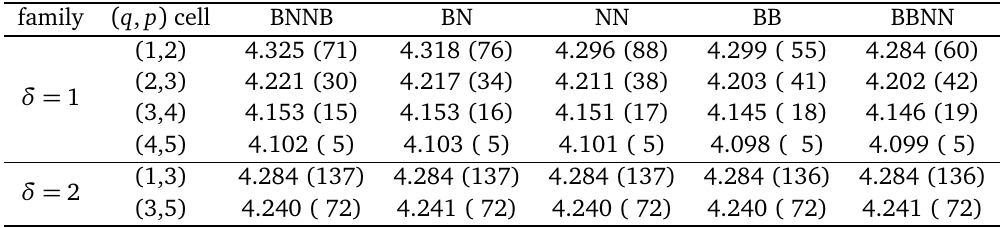
Table 3: The DFT energy (eV) of the indirect band gap at different twist angles and stacking sequences. In parenthesis: energy difference between the direct and the indirect band gap in